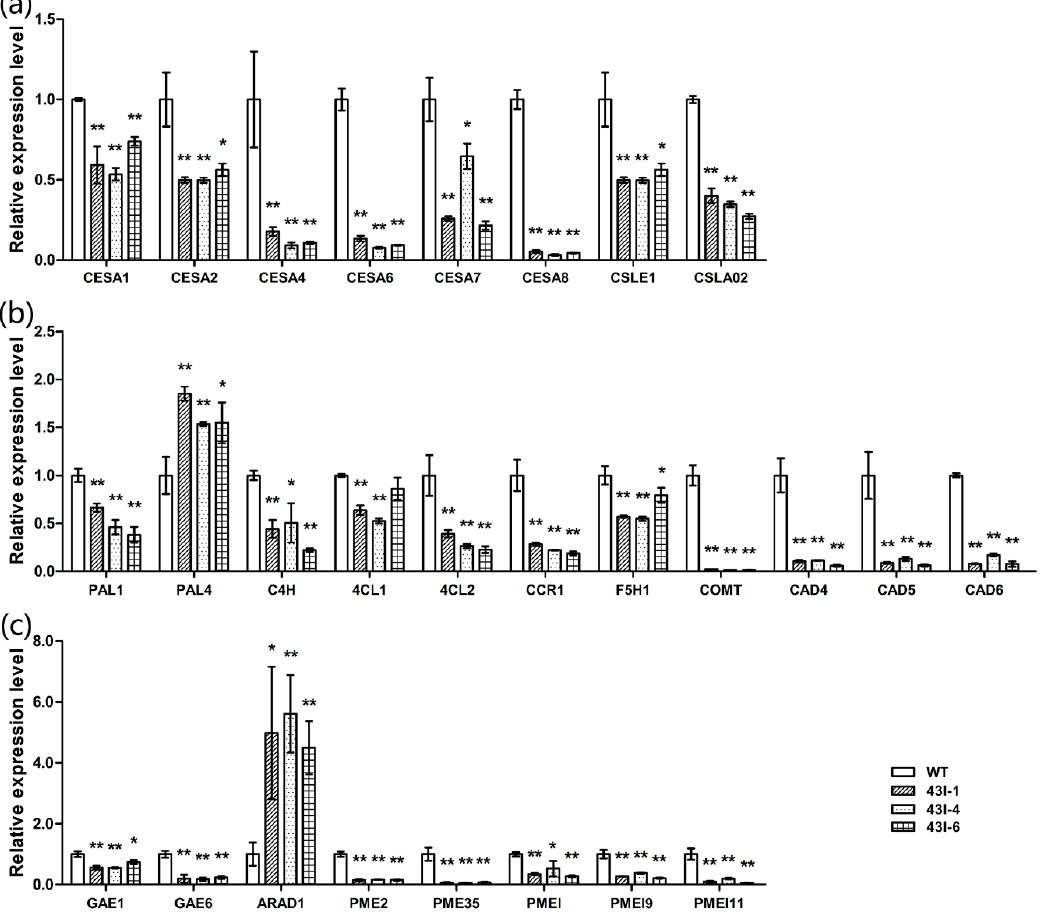
Figure 5. The expression patterns of genes related to cellulose ( a ), lignin ( b ) and pectin ( c ) in the stem of oilseed rape after silencing BnMYB43 gene family. Expression level of each gene in WT was set as 1 ( a–c ). Expression level of 25SrRNA was used as control reference. Values are means ± SD ( n = 3 biological replicates). Asterisks indicate significant or extremely significant differences from the control (*, 0.01 ≤ p < 0.05; **, p < 0.01) using one-way ANOVA.